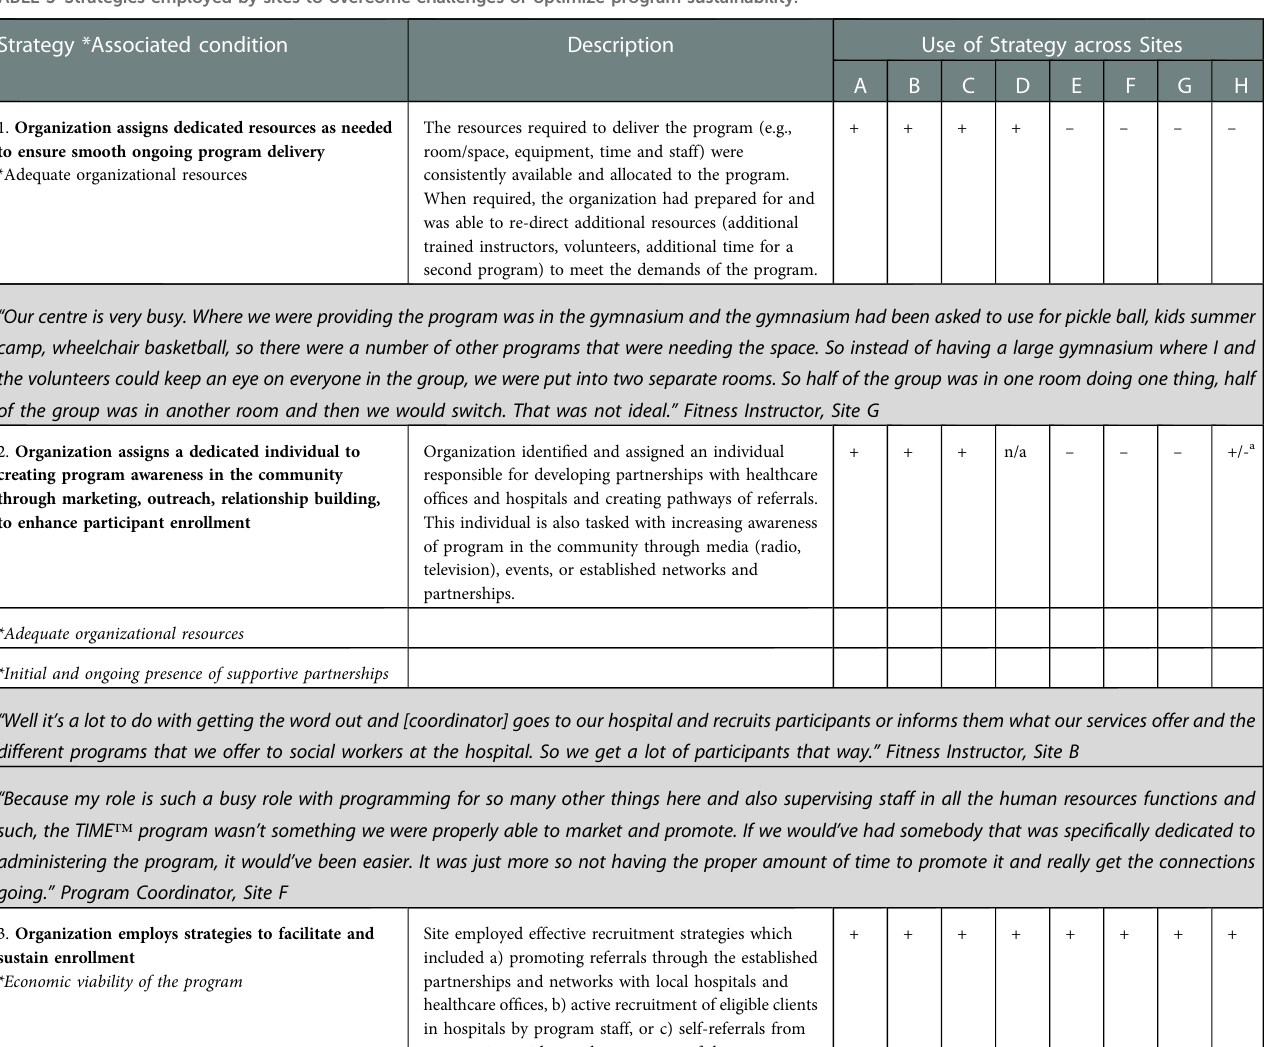
TABLE 5 Strategies employed by sites to overcome challenges or optimize program